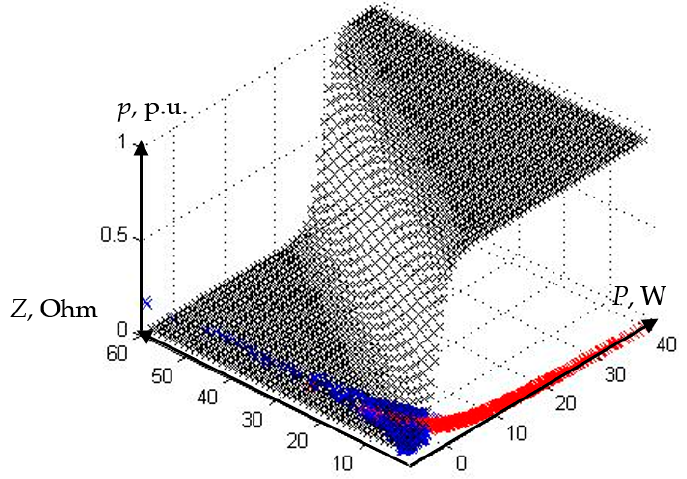
Figure 8. Surface characterizing the probability that an arbitrary mode belongs to the class α .